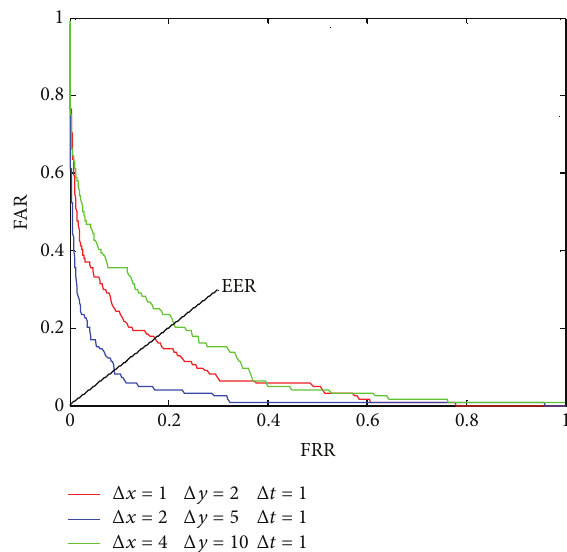
Figure 11: The ROC curves under different shift lengths along 𝑥 - and 𝑦